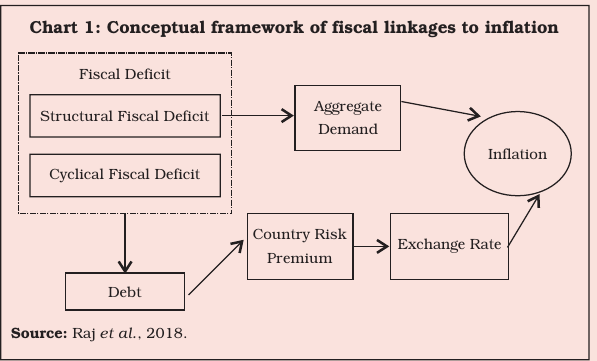
Chart 1: Conceptual framework of fiscal linkages to